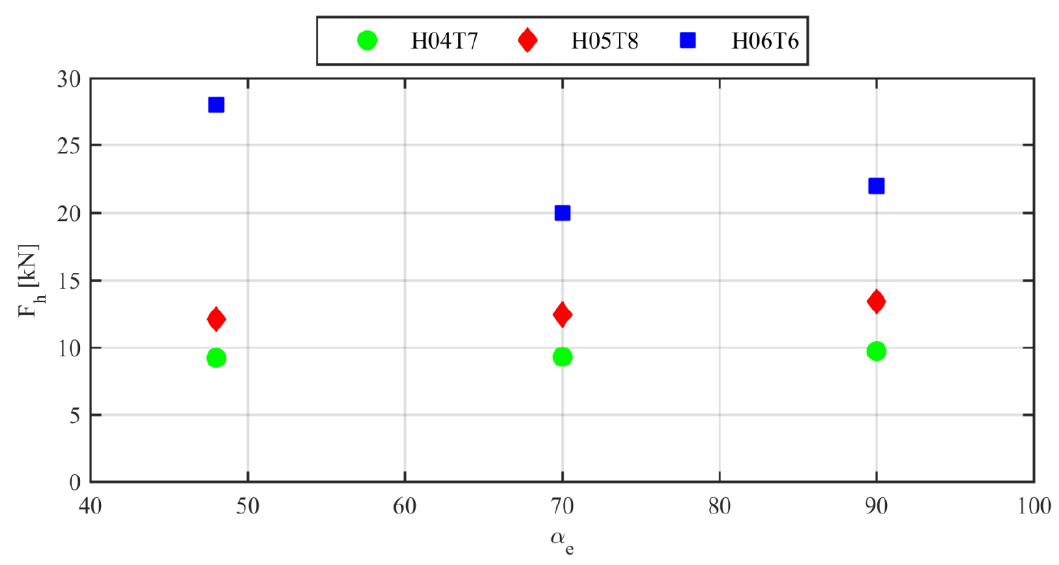
Figure 8. Mean peak force over the extremity angle of the recurve for pulsating conditions on the wall.